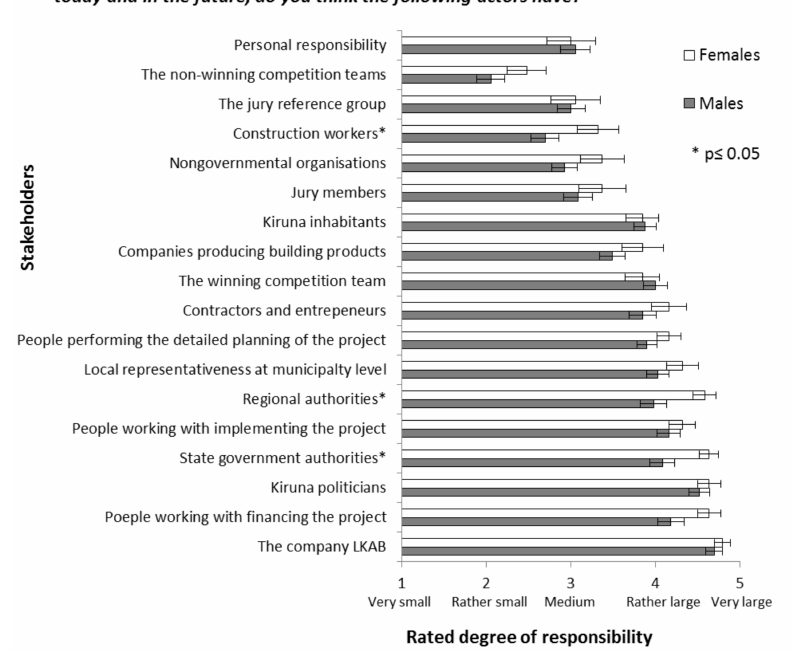
Figure 4. Mean values for the degree of responsibility for environmental impacts in the Kiruna project attributed by male and female participants to a range of different stakeholders. Error bars represent the standard error of